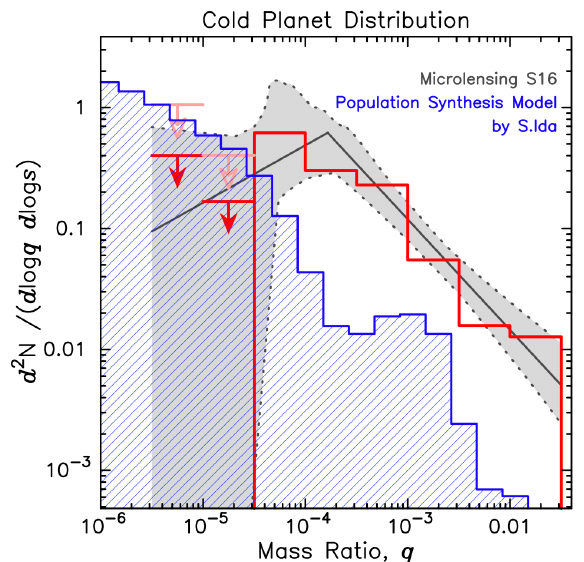
Figure 1. Microlensing mass ratio function [36] beyond the snow-line (in red) compared to the [5] core accretion population synthesis model (in blue). The population synthesis model underproduces wide separation planets by a factor of 10 for all mass ratios above the break at q ∼ 10 − 4 . The mass ratio function is modeled with a broken power law with the grey shaded region indicating the 1 σ contours (courtesy of D.